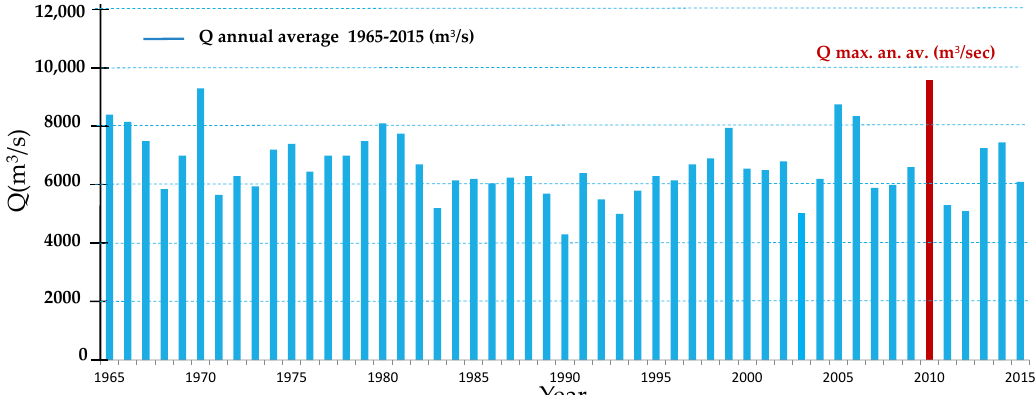
Figure 2. Variation of the average annual flows at the entrance to the Danube Delta, between 1965 and 2015.